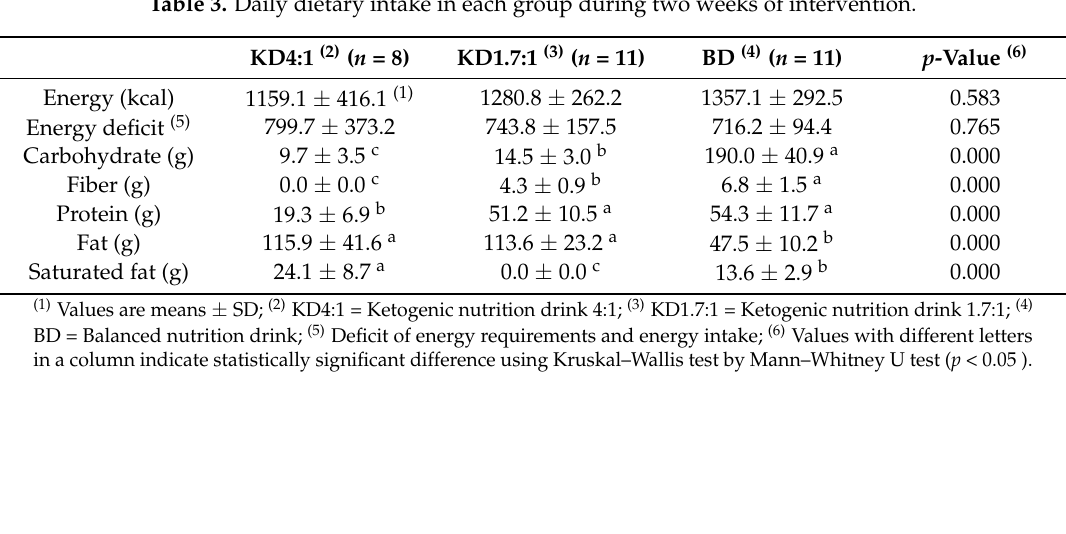
Table 3. Daily dietary intake in each group during two weeks of